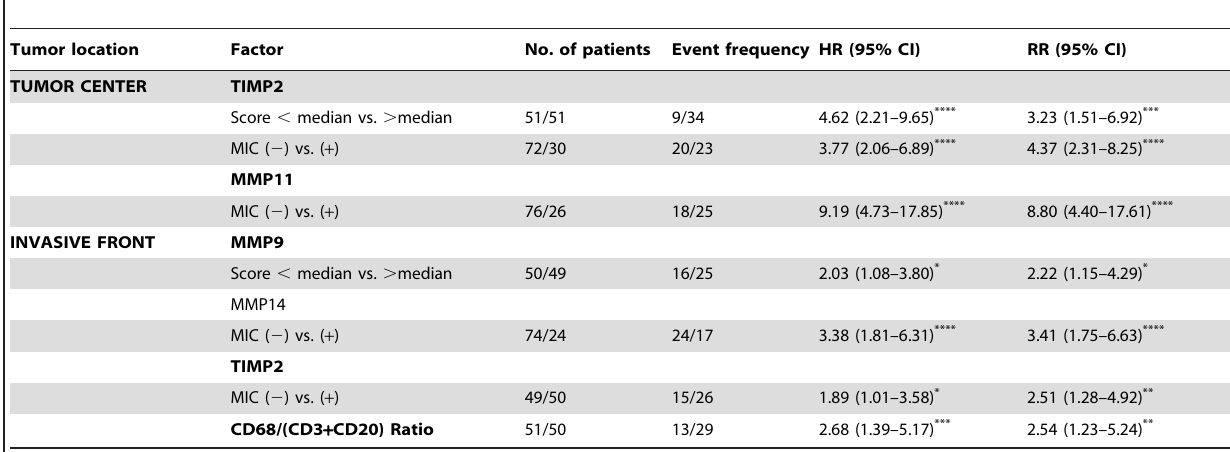
Table 4. Cox’s univariate (HR) and multivariate (RR) analysis of the significant relationships between MMPs, TIMPs expression or CD68/(CD3 + CD20) ratio at the tumor center or at the invasive front, and relapse-free survival.